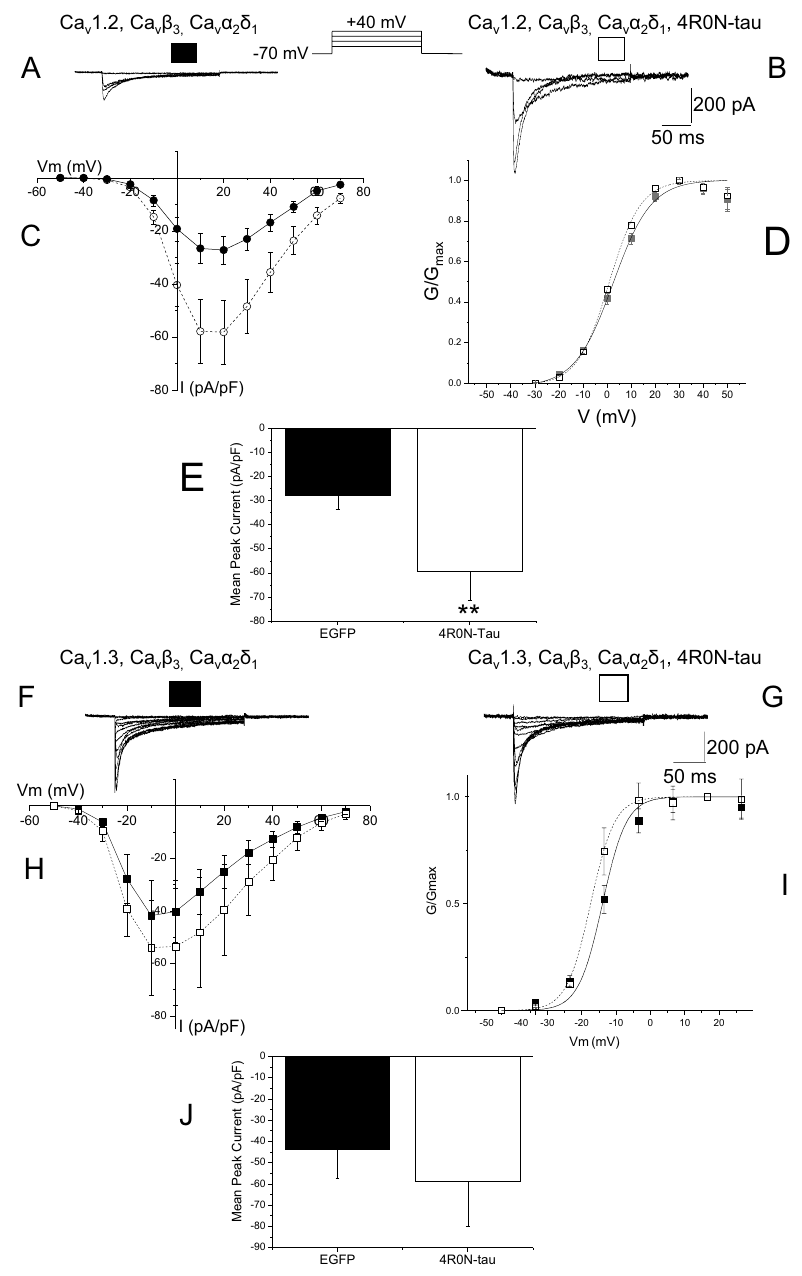
Figure 4. Co-expression of 4R0N-tau augments macroscopic Ca V 1.2-mediated L-type Ca 2+ current. Representative whole-cell Ca 2+ currents from tsA-201 cells expressing Ca V 1.2, Ca V β3, Ca V α2δ1 subunits in the absence ( A ) ( ● ) (n = 19) and presence ( B ) ( ◯ ) of co-expressed 4R0N-tau (n = 19). Enhancement of macroscopic current was observed throughout the voltage range ( C ) and was not accompanied by a shift in activation ( D ) (V 50 EGFP: 2.42 ± 0.98 mV, V 50 4R0N-tau: 2.17 ± 1.33 mV). ( E ) Co-expression of 4R0N-tau caused a significant increase in peak Ca V 1.2-mediated L-type current density from − 28.0 ± 5.6 pA/pF to − 59.4 ± 12.1 pA/pF (** p > 0.02). Representative whole-cell macroscopic currents from tsA-201 cells expressing Ca V 1.3, Ca V β3, Ca V α2δ1 subunits in the absence ( F ) ( ● ) and presence ( G ) ( ◯ ) of co-expressed 4R0N-tau. As observed with Ca V 1.2-mediated current, enhancement of Ca V 1.3-mediated current was observed throughout the voltage range ( H ) without any change in voltage dependence of activation ( I ). ( J ) The enhancement of peak Ca V 1.3-mediated L-type current density by co-expression of 4R0N-tau did not reach significance ( p =